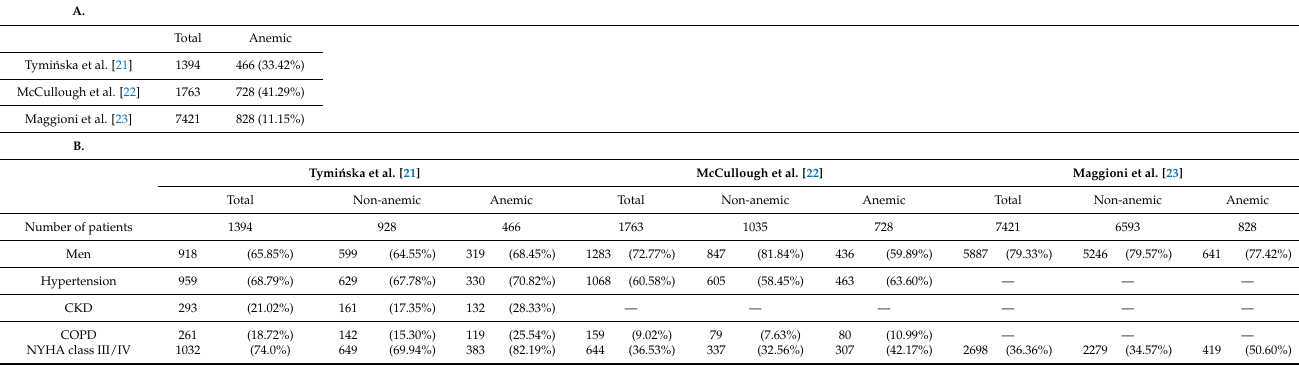
Table 2. A. Prevalence of anemia among heart failure patients. B. Features of heart failure patients with and without